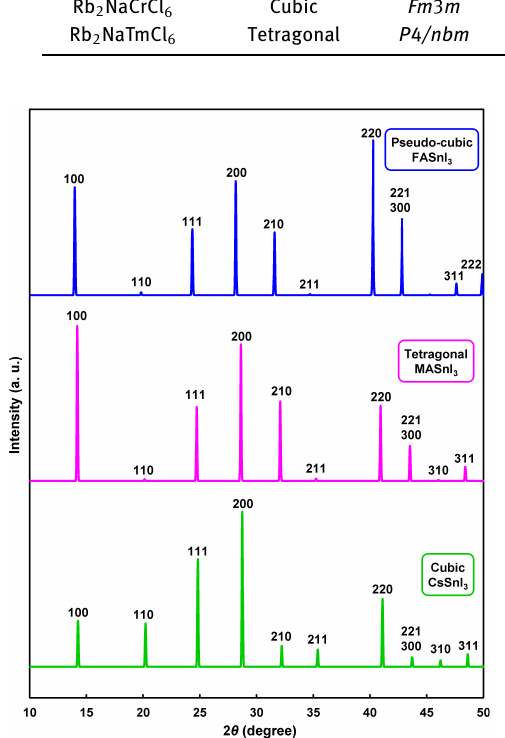
Figure 21: Calculated X-ray diffraction patterns of HC(NH 2 ) 2 SnI 3 , CH 3 NH 3 SnI 3 , and CsSnI 3 .